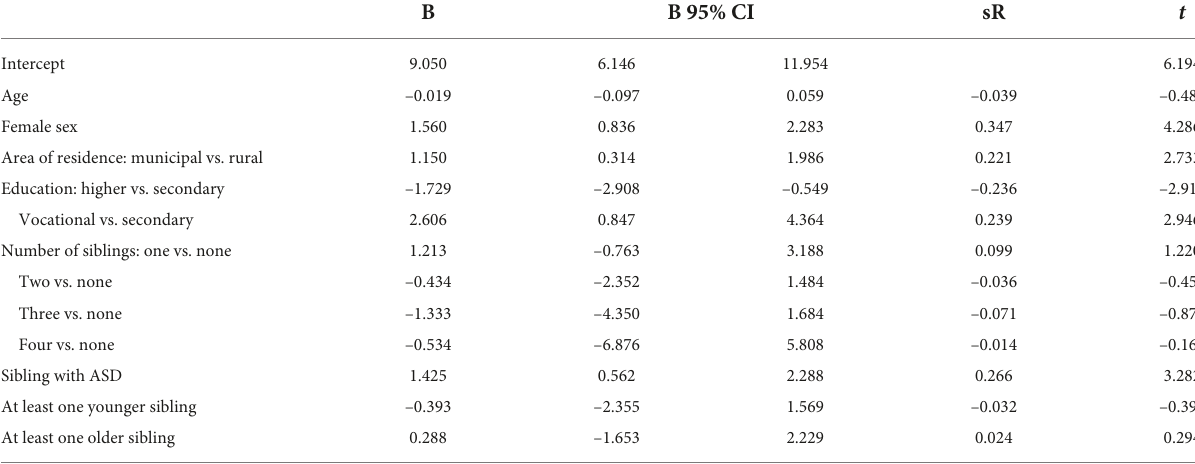
TABLE 2 Parameters of the linear regression model predicting the Beck Depression Inventory score in the studied group of adults.